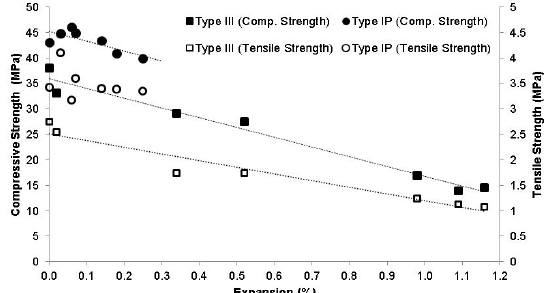
Figure 10. Relationship between the tensile and compressive strengths versus expansion.